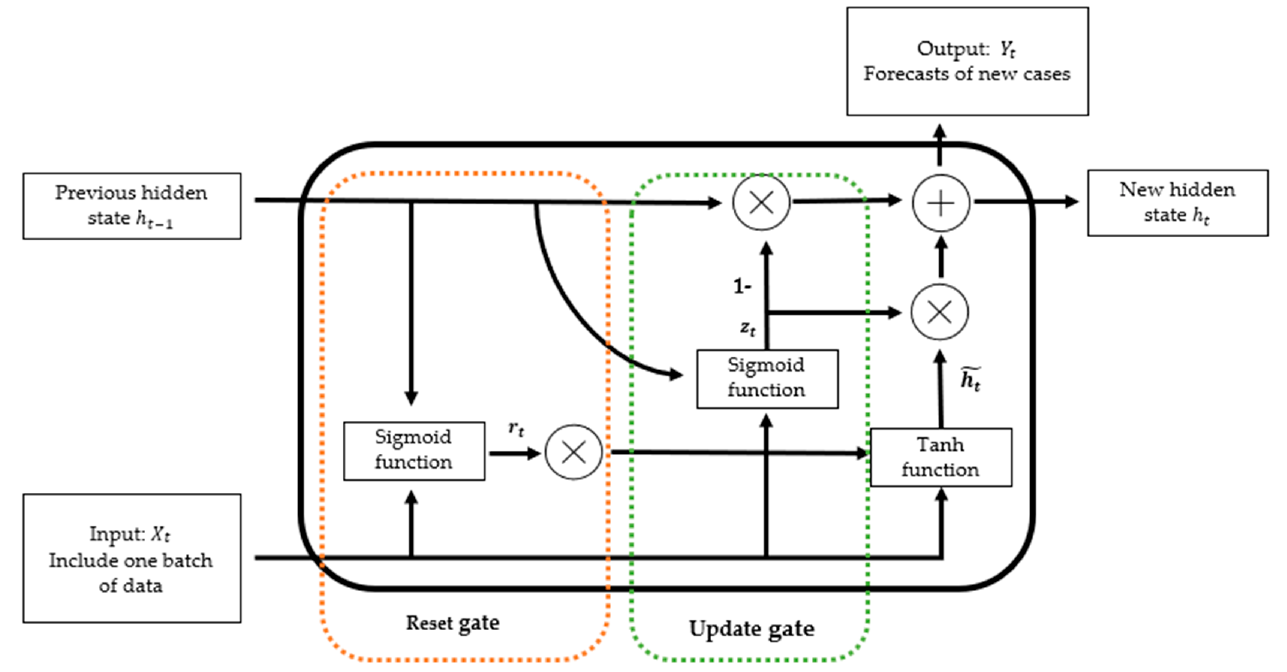
Figure 4. Gate recurrent unit (GRU) structure. The sigmoid function used in the reset gate and update gate of the GRU to decide the amount of information for forgetting and updating. The tanh function is used to calculate the new hidden state h t − 1 . Table 2. Gate recurrent unit (GRU) formula.